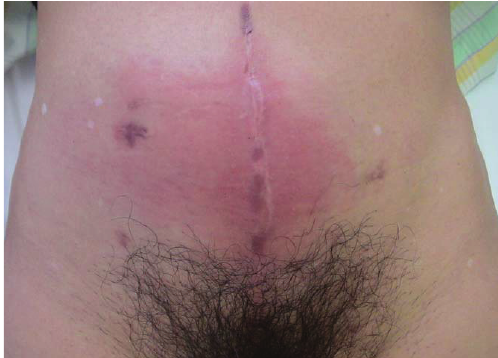
Figure3:Axialcontrast-enhancedcomputedtomographyimagesof the abdomen showing a fistula (arrowheads) between the neoblad- der and skin, without apparent ischemia of the neobladder ileum.